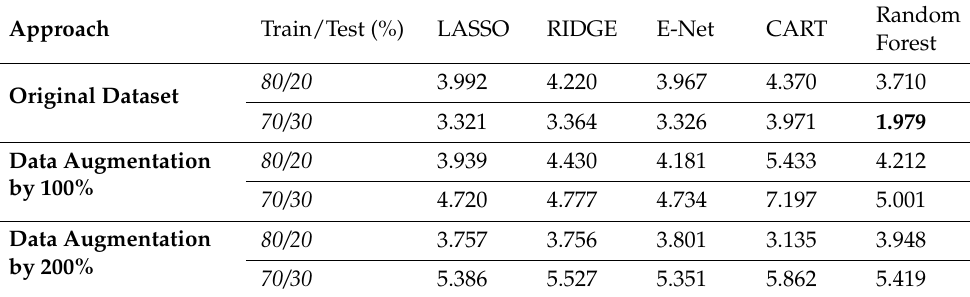
Table 1. Model performances, as RMSE, in the regression task.